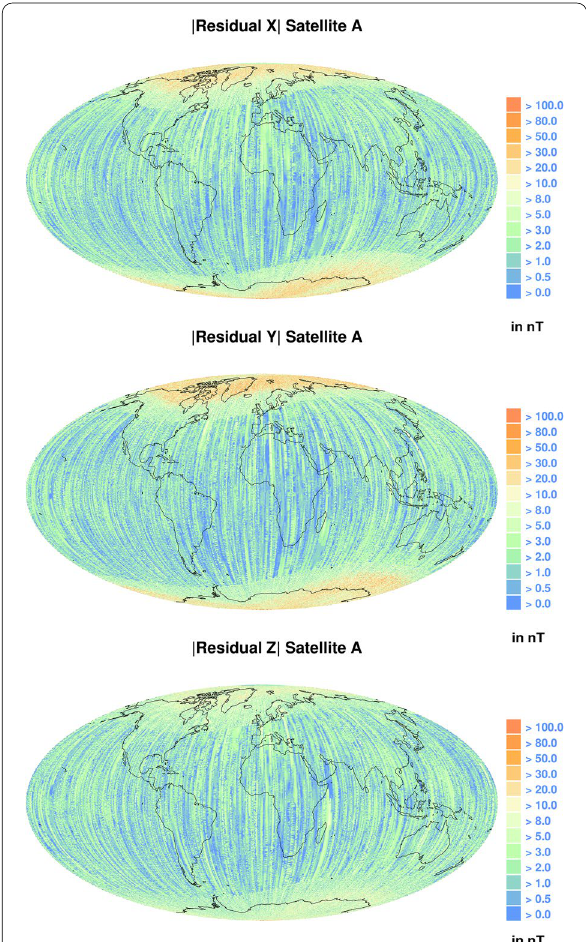
Fig. 5 Global maps of the Mag.num satellite data residuals. Top: X component, middle: Y component, bottom: Z component. Shown are the results for Swarm satellite Alpha, the residuals for satellites Bravo and Charlie are distributed similarly